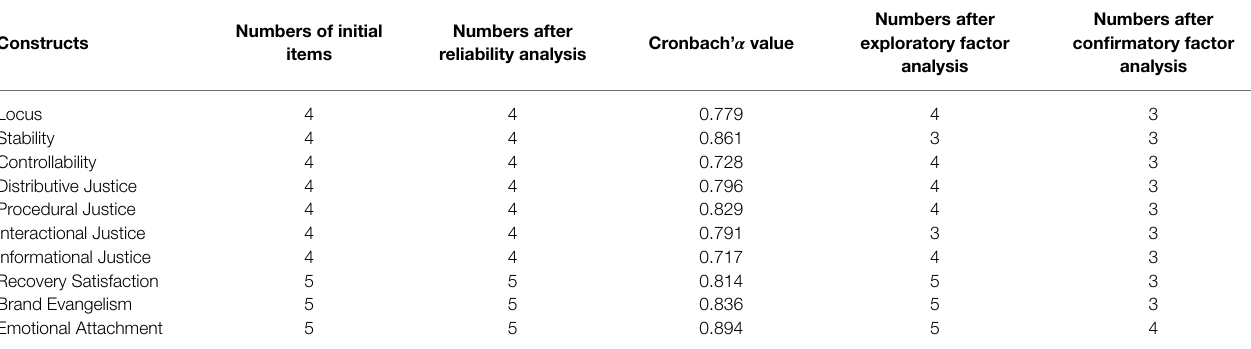
TABLE 1 | Results of reliability and validity analysis.